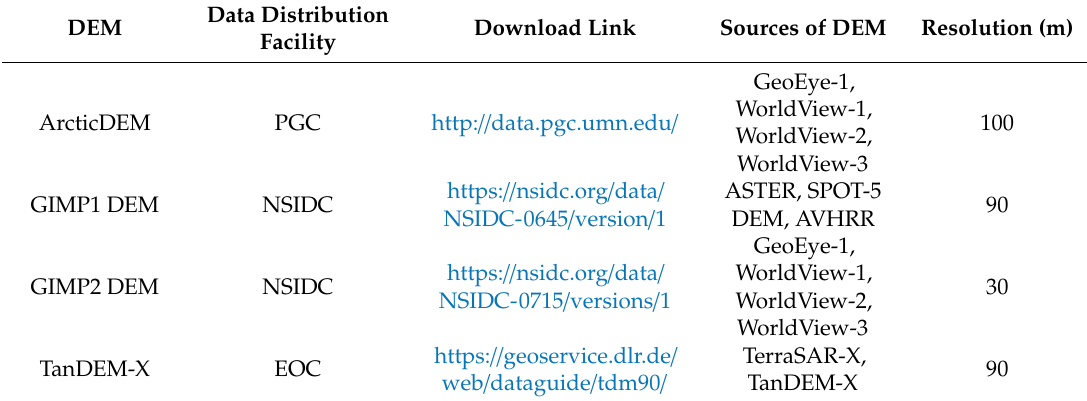
table of IceBridge data used for the accuracy evaluation of DEM products. Table 1. Four Greenland DEMs used in this study.